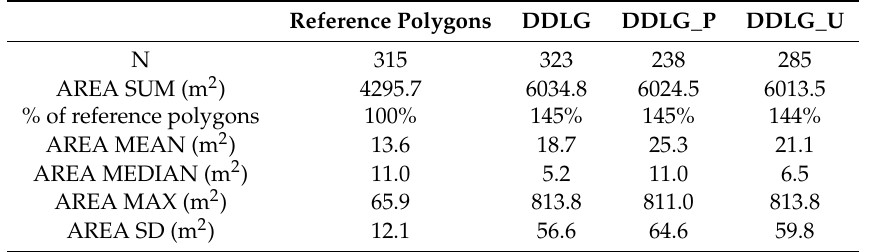
Table A4. Basic statistics summary (number and area) of deadwood-patches, identified by the three classification scenarios: Random forest (RF) classification (DDLG), RF classification with post-processing (DDLG_P), and with additional deadwood-uncertainty filter (DDLG_U), compared to the visually delineated reference polygons used for